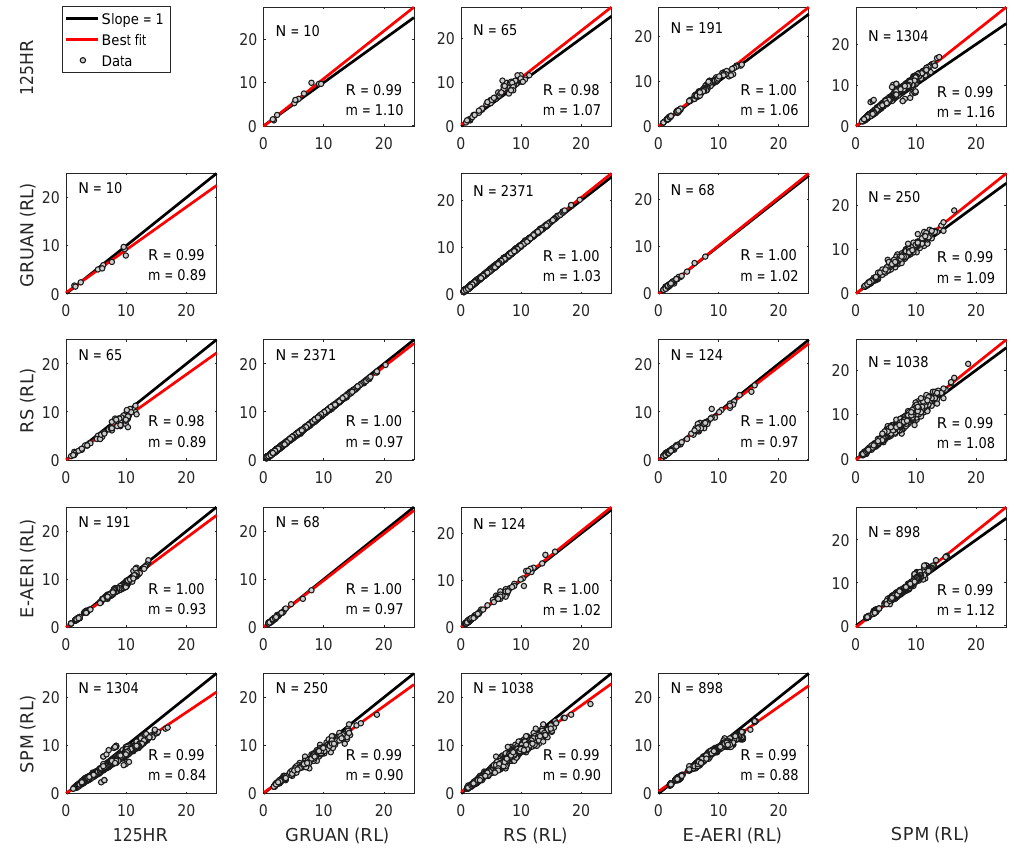
Figure 11. Water vapour total column (mm PWV) correlations between instruments at the Ridge Lab. Data used for the radiosonde and GRUAN comparisons with the 125HR have been smoothed with the MUSICA averaging kernels. A high-resolution version of this figure can be found in the Supplement as Fig.